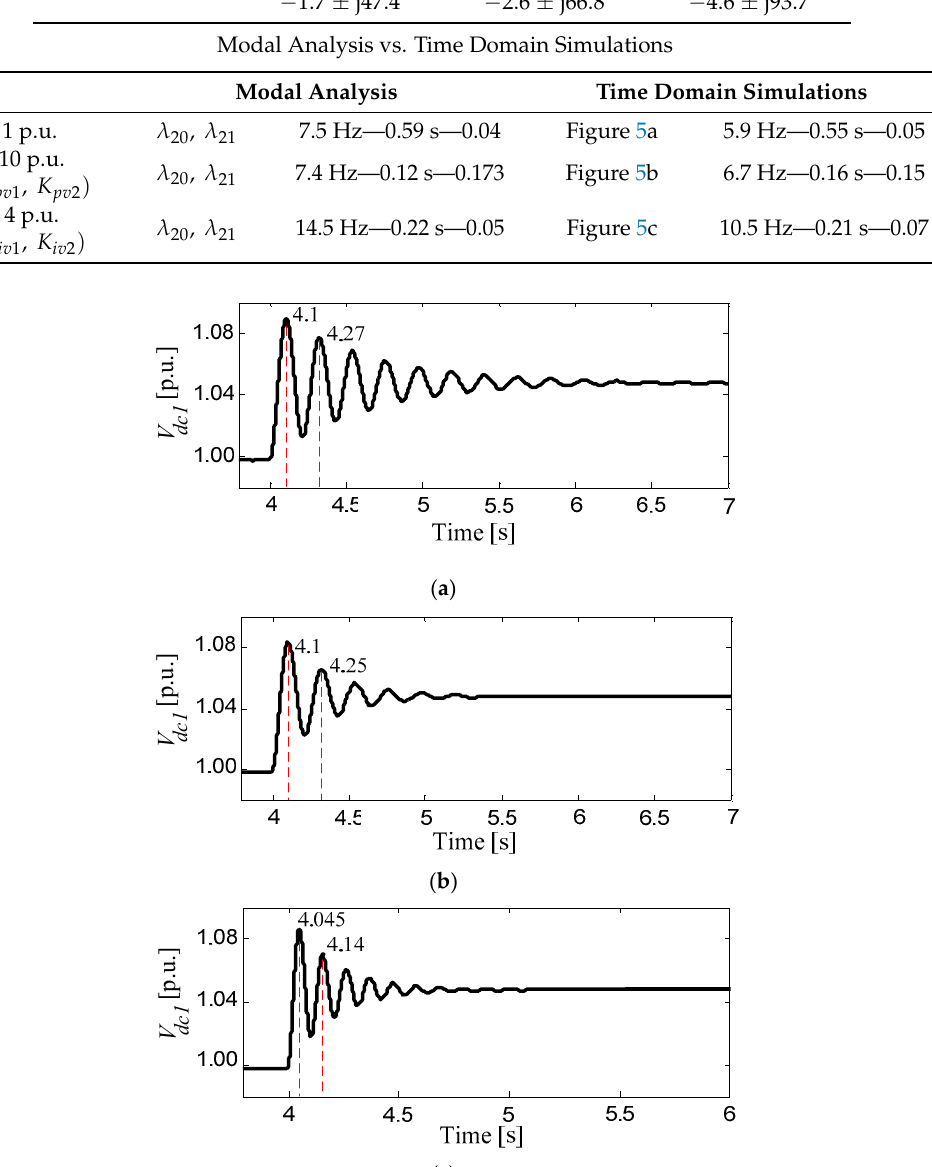
and V ∗ from 1 dc 1 dc 2